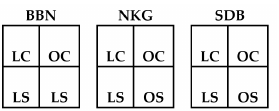
Figure 2. Experimental design. BBN = “Bihigubaani” replicate, NKG = “Nayilikurugu” replicate, SDB = “Sabdaboya” replicate, LS = Laribako sprayed, LC = Laribako control, OS = Olodo sprayed, and OC = Olodo control.